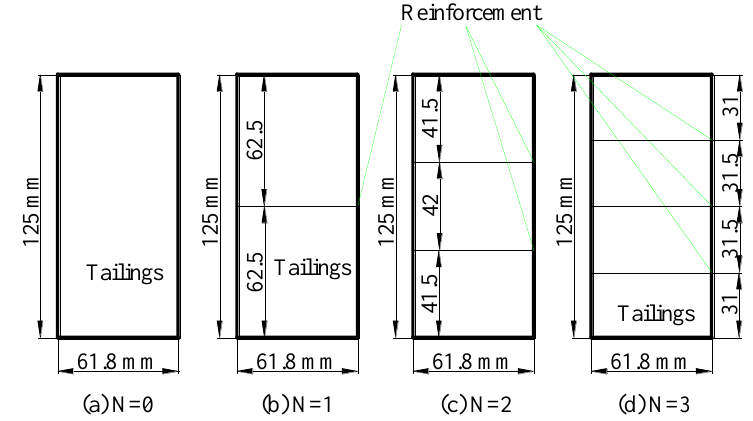
Figure 3. Reinforcement layout of triaxial specimens with different reinforcement layers.